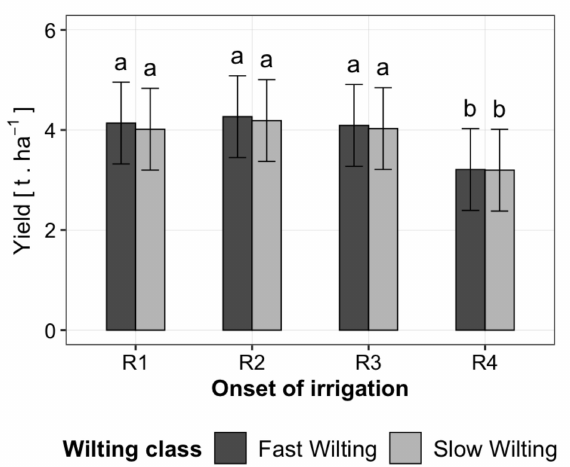
Figure 6. Soybean seed yield of each wilting class under different onset irrigations (R1, R2, R3, and R4). Same letters are not significantly different (Tukey’s; p -value < 0.05). Whiskers denote standard